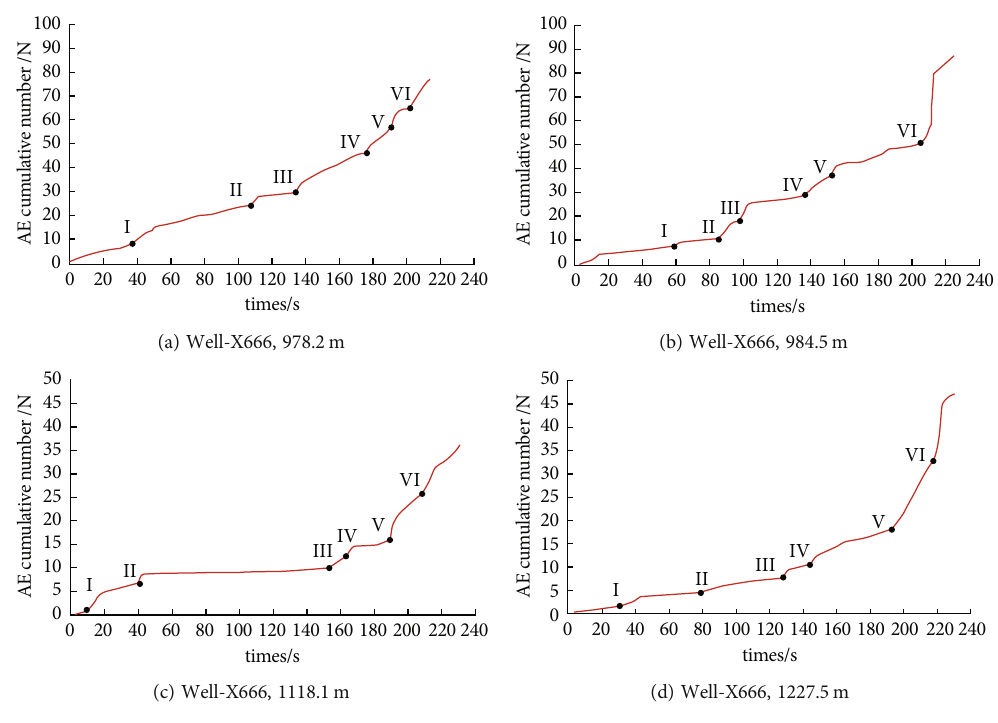
Figure 3: The cumulative number-time curves of the AE experiment of Carboniferous volcanic rocks in the Chepaizi Uplift.